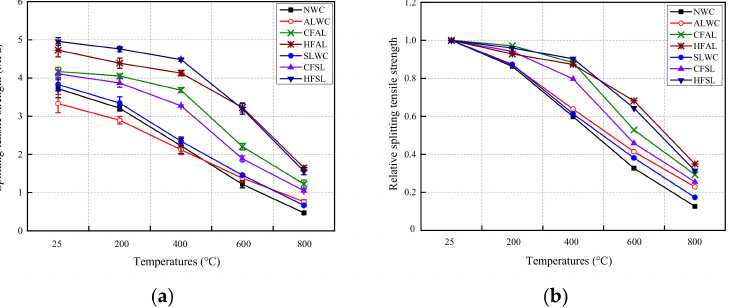
Figure 7. Temperature effect on splitting tensile strength: ( a ) absolute splitting tensile strength; ( b ) relative splitting tensile strength.